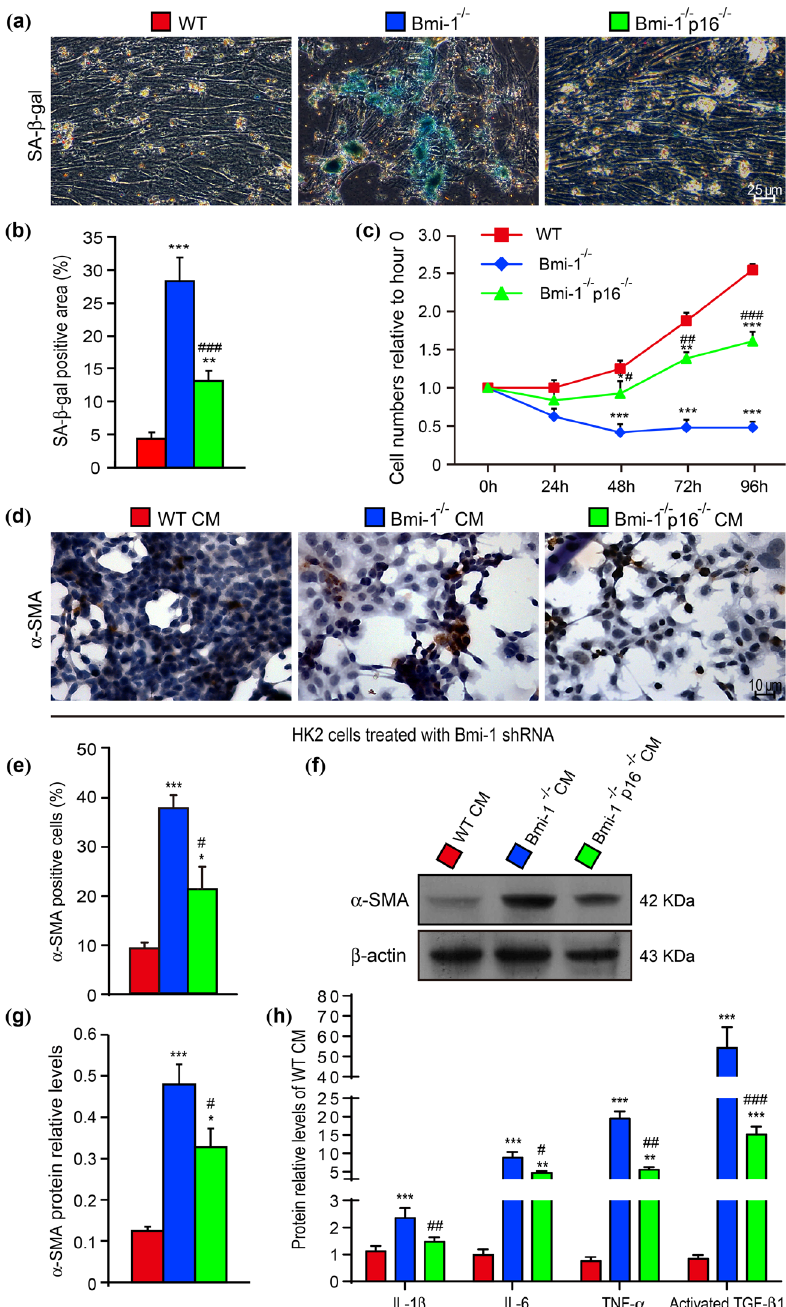
Figure 6. P16 deletion ameliorated enhanced EMT induced by SASP of senescent renal interstitial fibroblasts. ( a ) Representative micrographs of cells stained cytochemically for senescence associated- β -galactosidase (SA- β -gal). ( b ) Percentage of SA- β -gal-positive area relative to total area. ( c ) Fifth-passage renal interstitial fibroblast proliferation determined by CCK-8 assays and spectrophotometry at 450 nm. Cell number determined on indicated hours is presented relative to cell number at hour 0. Six biological replicates were used for these studies per experiment. Values are mean ± SEM from six determinations per group. * P < 0.05, ** P < 0.01, *** P < 0.001 compared with WT group; # P < 0.05, ## P < 0.01, ### P < 0.001 compared with Bmi - 1 − / − group. ( d ) Bmi - 1 shRNA- transfected HK2 cells sorted for EGFP; EGFP-positive HK2 cells were treated with isometric conditioned medium (CM) from renal interstitial fibroblasts and normal culture medium for 4 days and were stained immunocytochemically for α -SMA. ( e ) Percentage of α -SMA-positive cells relative to total cells. ( f ) Western blots of HK2 cell extracts showing α -SMA. β -actin was the loading control. ( g ) α -SMA protein relative to β -actin, assessed by densitometric analysis. ( h ) IL-1 β , IL-6, TNF- α , or activated IL-1 β concentration in CM by ELISA and assessed by densitometric analysis relative to WT CM. Six biological replicates were used for these studies per experiment. Values are mean ± SEM from six determinations per group. * P < 0.05, ** P < 0.01, *** P < 0.001 compared with WT CM group; # P < 0.05, ## P < 0.01, ### P < 0.001 compared with Bmi - 1 − / − CM